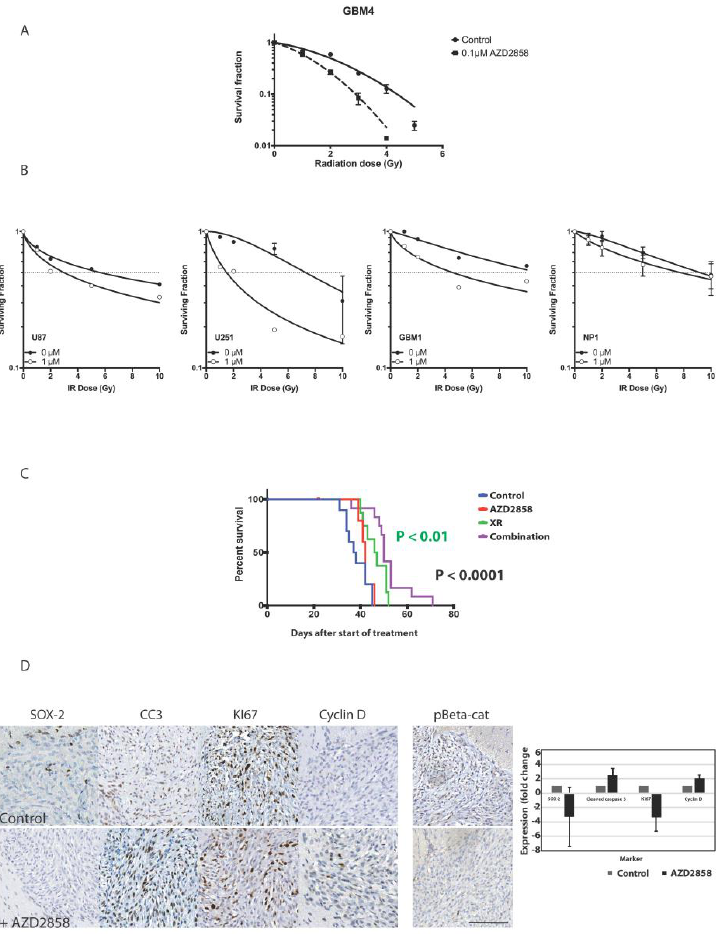
Figure 4. Combination treatment with AZD2858 enhances radiosensitivity in vitro and in vivo. ( A ) The patient-derived stem cell-like glioma cell line GBM4 was exposed to submicromolar con- centrations of AZD2858 (0.1 µ M) for 72 h after treatment with single doses of radiation (0–5 Gy). Radiosensitization was assessed in a clonogenic assay. ( B ) Additional established (U87, U251) and the patient-derived stem cell-like glioma cell line GBM1, as well as a normal cell control, neural progenitor cells (NP1), were treated with AZD2858 at 1 µ M for 72 h after radiation treatment (1–10 Gy) and radiosensitization was assessed using MTT assays. ( C ) In a U87 orthotopic BALB/c Nude mice model animals were allocated to treatments six weeks after intracranial injection with either XR (5 Gy × 3), AZD2858, saline (control), or XR + AZD2858. Combination of XR with AZD2858 led to improved median survival compared to control ( p < 0.0001) and to XR alone ( p < 0.01). ( D ) In treated tumors from the U87 orthotopic intracranial BALB/c Nude mice model, a decrease in Sox-2 (stemness), increase in cleaved caspase 3 (apoptosis), decrease in the expression of the proliferation marker Ki67, and increase in cyclin D (cell cycle) as determined by immunohistochemistry was observed. Phosphorylated beta-catenin levels are also decreased after treatment. Representative images from untreated (control) and tumors treated with AZD2858 are shown after sectioning of harvested mouse brains and staining for the various markers by immunohistochemistry. Scale bar = 50 µ m. Having confirmed efficient delivery to intracerebral tumor site and potential sensi- tization to XR in vitro, we carried out additional in vivo experiments using orthotopic U87 xenografts to assess the effect of combination treatment using AZD2858 at 30 mg/kg by oral gavage following targeted 3Gy × 4 days delivered using image-guided radiation (Xstrahl SARRP) compared to XR and drug alone. Combination treatment led to improved survival compared to control ( p < 0.0001) and to XR alone ( p < 0.01) (Figure 4C). No adverse effects on behavior or weight were observed. We also harvested brains from these